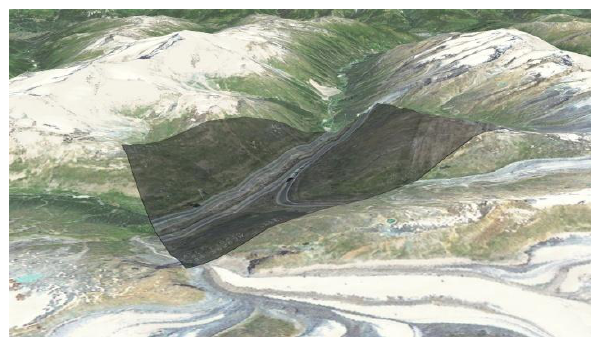
Figure 4 – Geo-referenced UAV acquisition